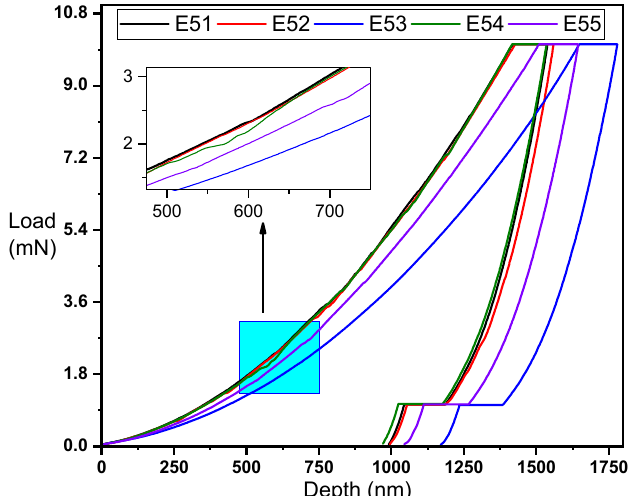
Figure 4. Load vs. depth profile of ZnO-incorporated epoxy coatings E51 (1%), E52 (2%), E53 (3%), E54 (4%), and E55